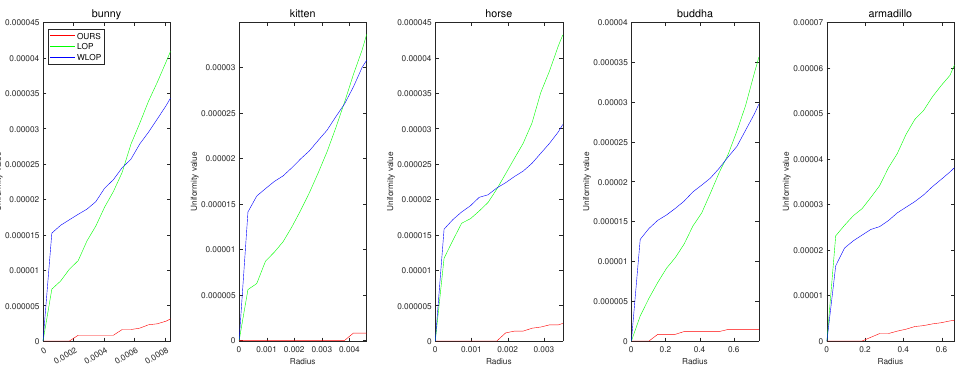
Figure 5. Quantitative results for the tangential noise cases. Each column shows the results of algorithms applied to Horse, Bunny, Kitten, Buddha, and Armadillo. The x -axes in the plots indicate the radius of evaluating u . The ranges of the radius were determined proportional to the square roots of the ratios between the surface areas of point clouds and the numbers of points.